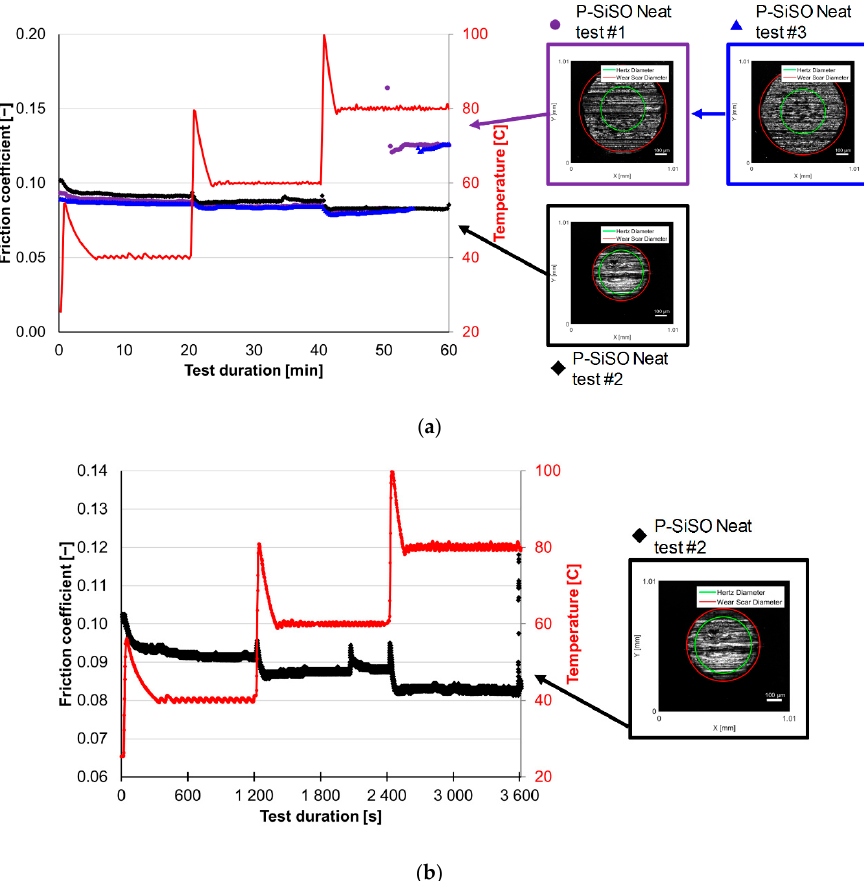
Figure 5. Results from V{300 N/40–80 °C /60 min}. ( a ) Three repeated tests with neat P-SiSO, where test #2 appears to pass the 80 °C level without step increase in friction; ( b ) higher resolution data examined for test #2 in ( a ) revealed that test #2 also displayed step increases in friction. Insets display ball wear scars corresponding to tests #1–3, respectively.